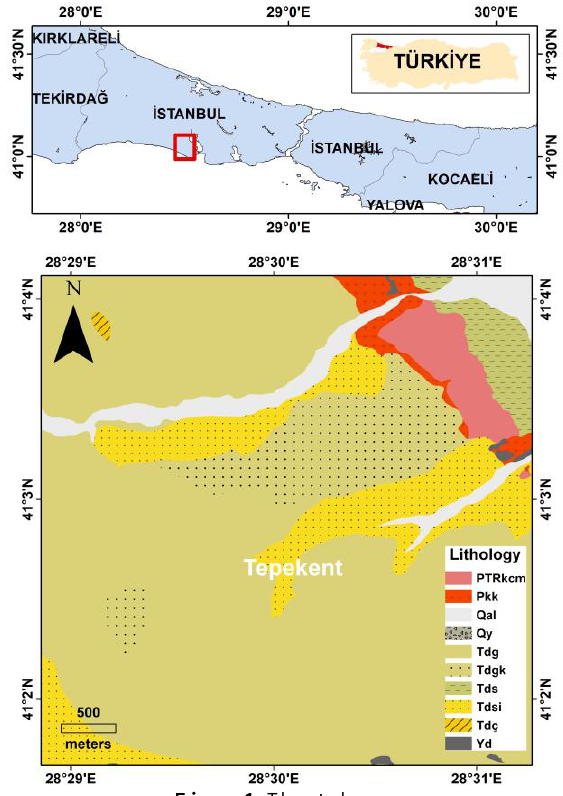
Figure 1. The study area. Table 1. Specifications of the Sentinel-1 data